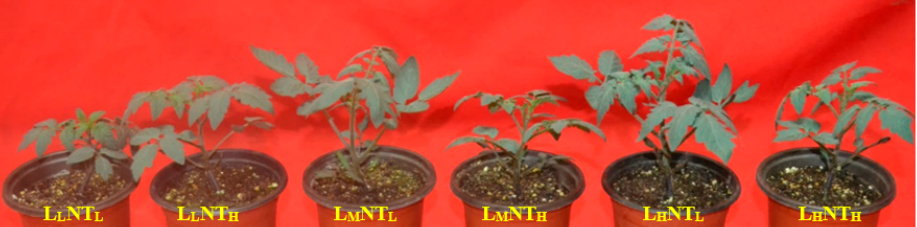
Figure 1. The phenotype of cherry tomato seedlings grown under different light intensity (LI) and night temperature (NT) conditions for 30 days. The LI and NT conditions of different treatments as follows: L L NT L , 250 µ mol m − 2 s − 1 and 15 ± 1 ◦ C; L L NT H , 250 µ mol m − 2 s − 1 and 18 ± 1 ◦ C; L M NT L , 300 µ mol m − 2 s − 1 and 15 ± 1 ◦ C, L M NT H , 300 µ mol m − 2 s − 1 and 18 ± 1 ◦ C; L H NT L , 350 µ mol m − 2 s − 1 and 15 ± 1 ◦ C; L H NT H , 350 µ mol m − 2 s − 1 and 18 ± 1 ◦ C.